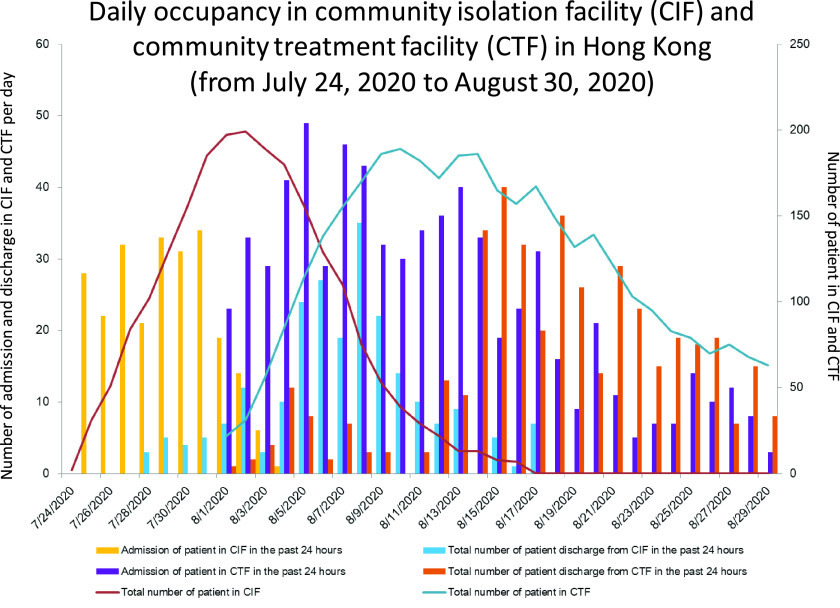
Daily occupancy in community isolation facility (CIF) and community treatment facility (CTF) in Hong Kong. In the CIF at Lei Yue Mun Park and Holiday Village, only site B was opened for step-down care of COVID-19 patients on July 24, 2020 (day 207). Site A was maintained in standby mode. Since the CTF at AsiaWorld-Expo adjacent to the Hong Kong International Airport opened on August 1, 2020 (day 215), and the community outbreak of COVID-19 was under control, the CIF was converted to standby mode on August 17, 2020 (day 231).